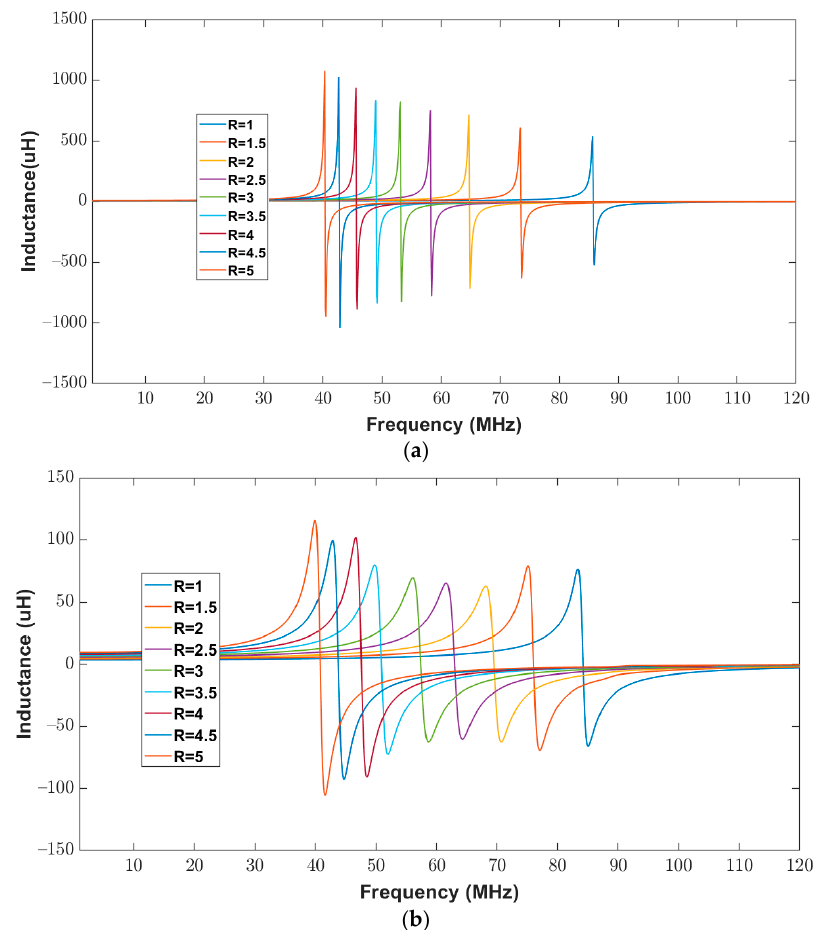
Figure 16. Inductance of elliptical planar inductors for the full range of frequencies from 20 Hz to 120 MHz with varying major-to-minor ratios while trace separation ( S ) and trace width ( W ) were kept constant at 400 μ m ( a ) Computed response using proposed model ( b ) Measured response from the impedance analyzer.